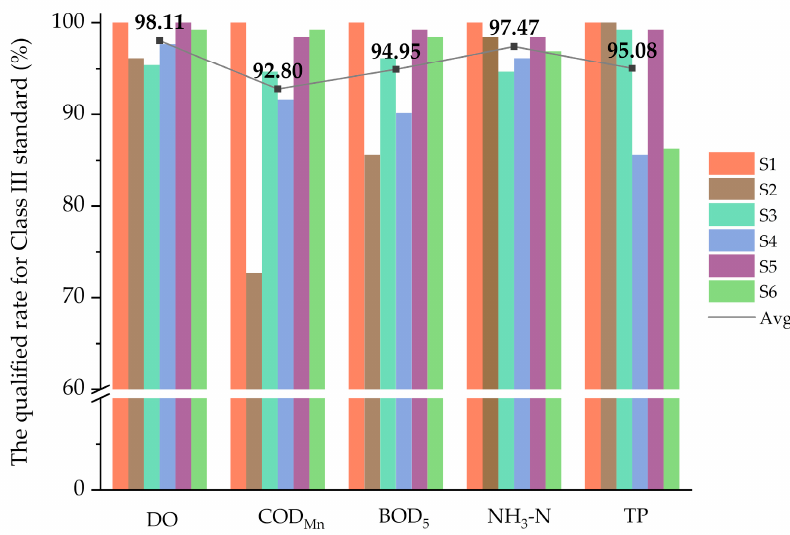
Figure 3. The qualified rate for Class III standard of each parameter in six sites.